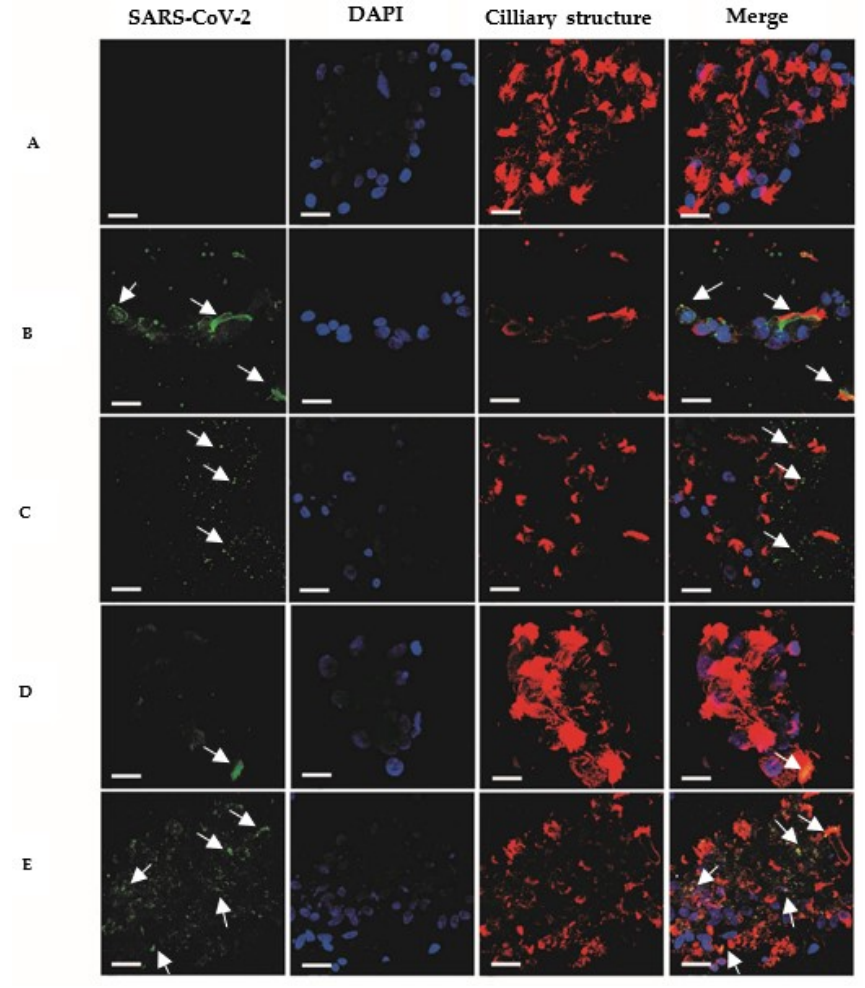
Figure 3. Nasal mucociliary mucosa of patients complaining of mild post-COVID-19 olfactory dysfunction. Negative control ( A ); positive control ( B ); patients ( C – E ). SARS-CoV-2 S/N proteins, in green; nucleic acid labeling (DAPI), in blue; ciliary structures-tubulin, in red. The “Merge” column shows all overlapping markups. Images ( C – E ) are representative of samples from 8 patients. The images were selected among a total of 24 images through three replicates. Scale bars represent 25 µ m. Arrows indicate viral antigen (nucleocapsid and spike proteins) staining.